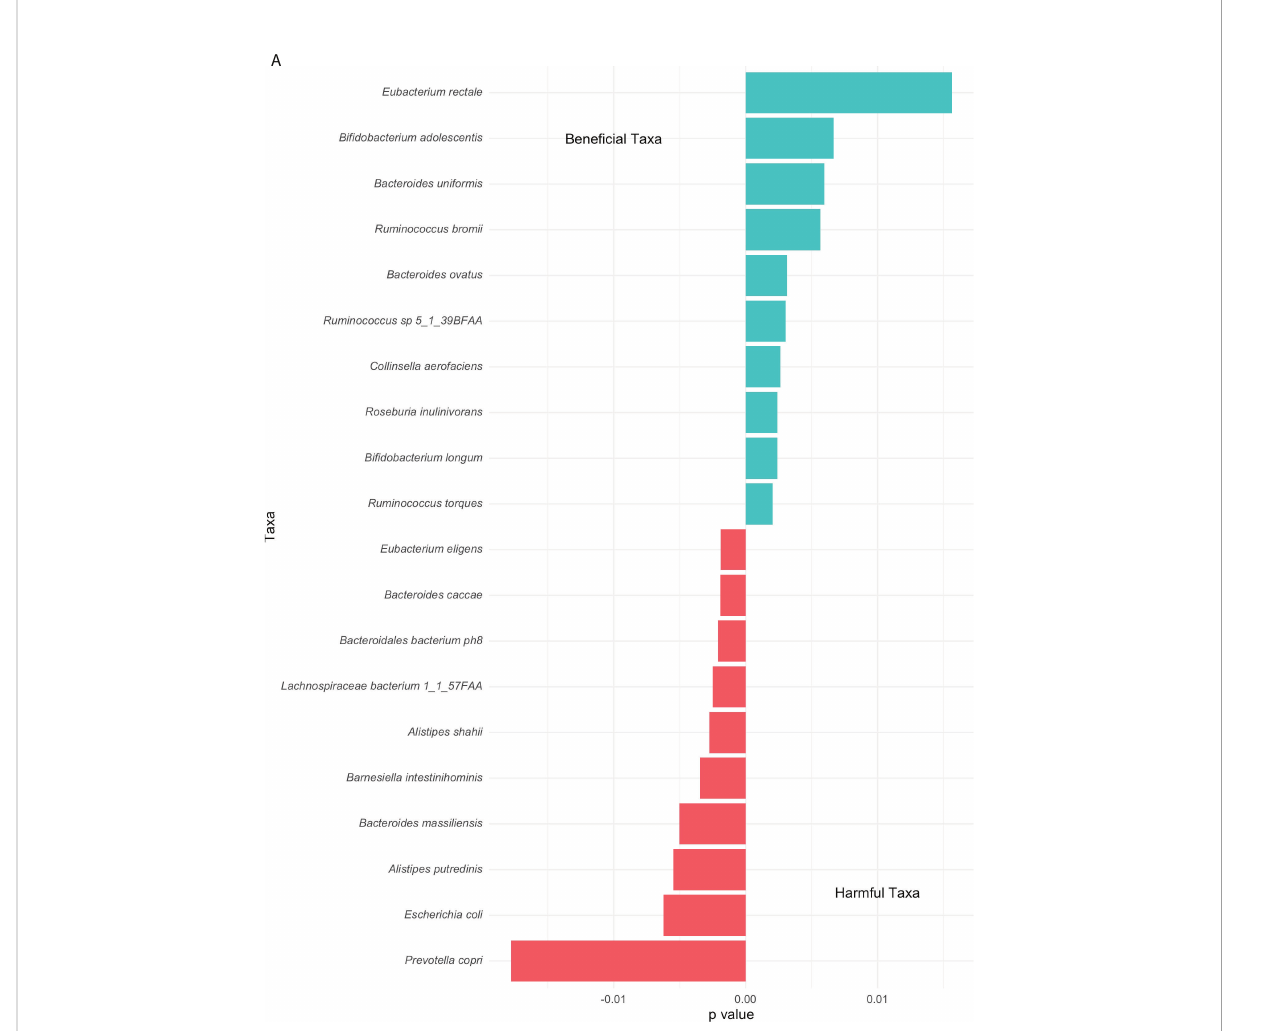
FIGURE 9 Bar chart of the network-wide SAFE enriched score of all metadata. This score is an indicator of effect size, allowing comparison across